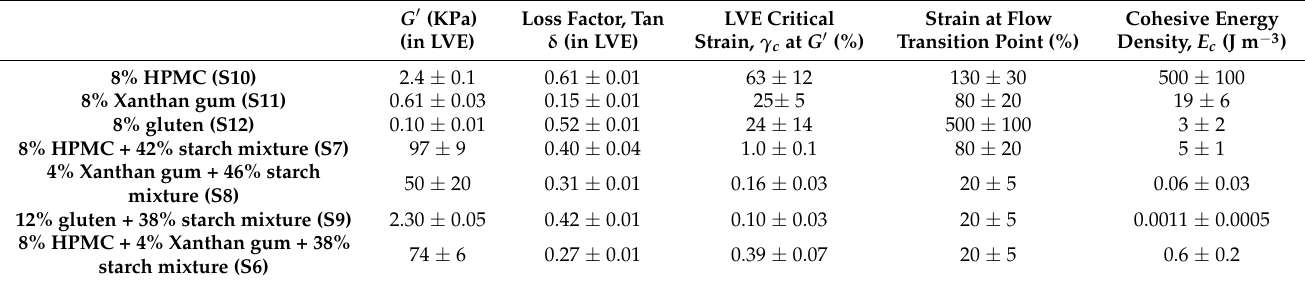
Figure 7. Rheology: Oscillatory amplitude tests performed on samples of starch/hydrocolloids mixtures. To all samples the water was added in a ratio 1:1, water:dry ingredients. Storage ( G (cid:48) , —–) and loss modulus ( G (cid:48)(cid:48) , - - - -) of 12% gluten, 38% starch mixture and water (purple line, S9), 4% xanthan gum and 46% starch mixture (orange line, S8), 8% HPMC and 42% starch mixture (blue line, S7), and 8% HPMC and 4% xanthan gum, 38% starch mixture and water (green line, S6), and starch mixture alone (pink line, S5). Starch mixture (starch mix) consists in all presented cases of 0.85 potato:0.15 corn starch. The lines represent averages of three independent experiments ( n = 3) and the error bars correspond to SD. All concentrations are given as ( w / w ). Only the data above the sensitivity of the rheometer ( G > 1 Pa) are shown. Pure HPMC (S10), xanthan gum (S11), and gluten (S12) solutions have elastic character ( G (cid:48) > G (cid:48)(cid:48) ), typical for gel-like systems and entangled polymer solutions. At the same con- centrations of polymers, xanthan solution had the highest tan δ ratio (Table 6), suggesting a more solid-like behavior. In addition, xanthan, which has charged side chains, had a G (cid:48)(cid:48) peak. Song et al. (2006) also observed a G (cid:48)(cid:48) peak in less concentrated xanthan solutions (i.e., 1% to 4%) [62]. G (cid:48)(cid:48) peaks are typically absent in linear unlinked polymers and may occur due to the relative motion between the polymer molecules, flexible end-pieces of chains and side chains, long network bridges, mobile single particles, agglomerates, or superstructures not linked or otherwise fixed in the network [63]. Table 6. The values of elastic modulus, G (cid:48) , calculated loss factor tan δ at 0.1% strain, critical strain, γ c at the end of linear viscoleasti range (LVE) in G (cid:48) , strain at the flow transition point, and cohesive energy density calculated as E c = 1 / 2 G (cid:48) × γ c 2 . G (cid:48)